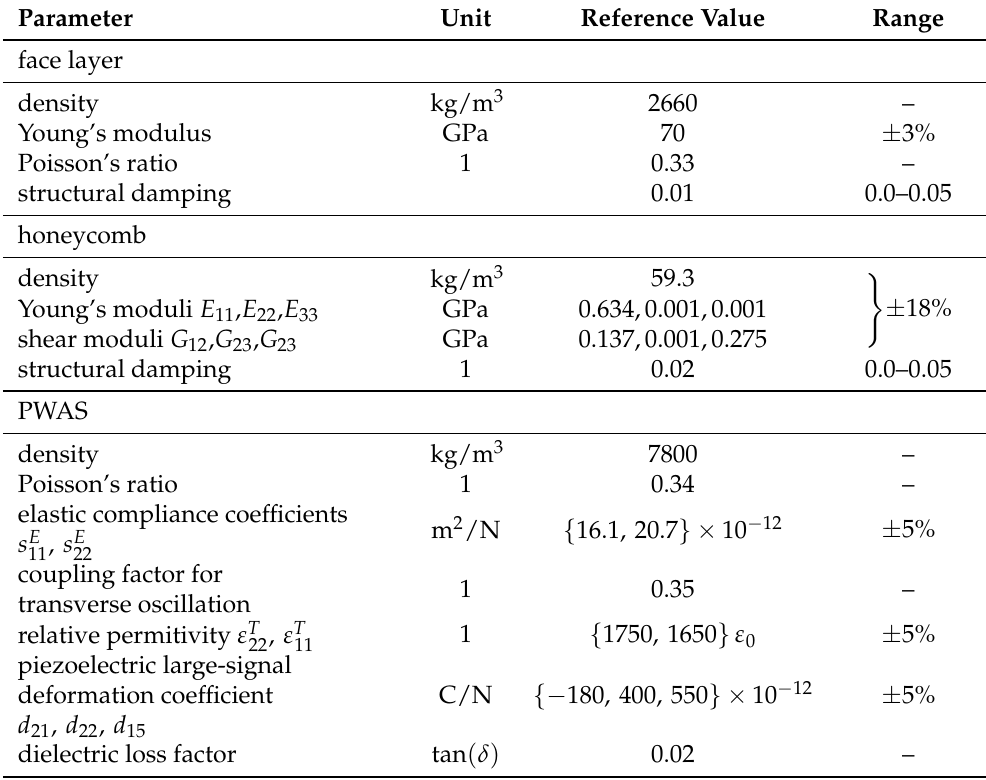
Table 1. Range for material parameter variations considered for the FE parameter